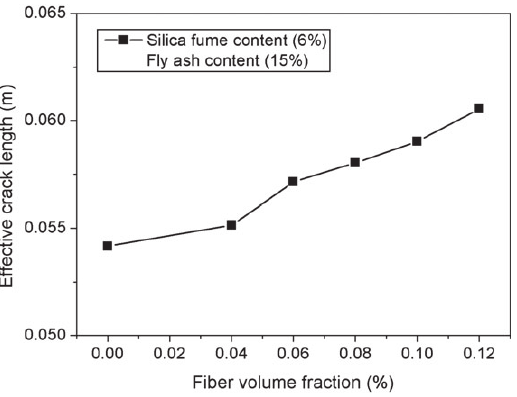
Figure 7 Effect of the polypropylene fiber on the fracture